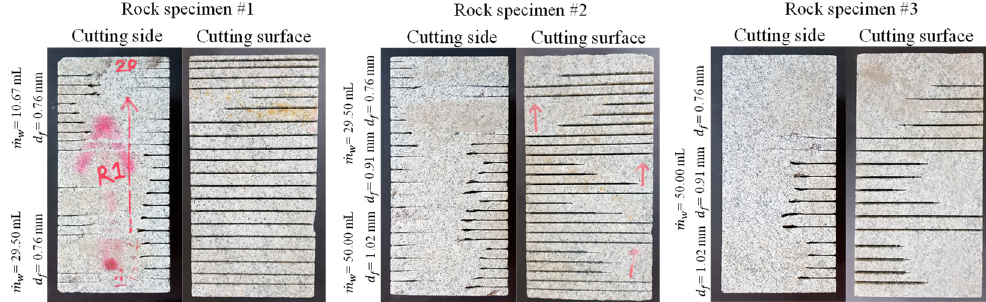
Figure 7. Cutting results with different focus diameters and WFRs on the granite specimens.